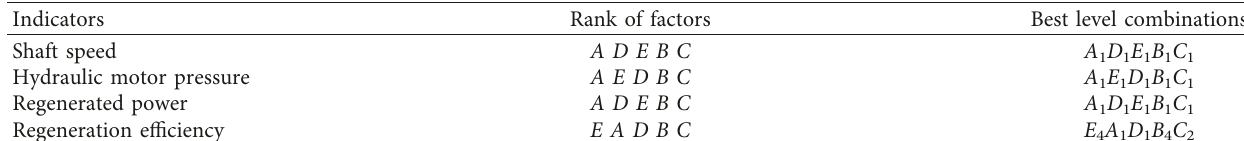
Table 10: The rank of factors and their combination.